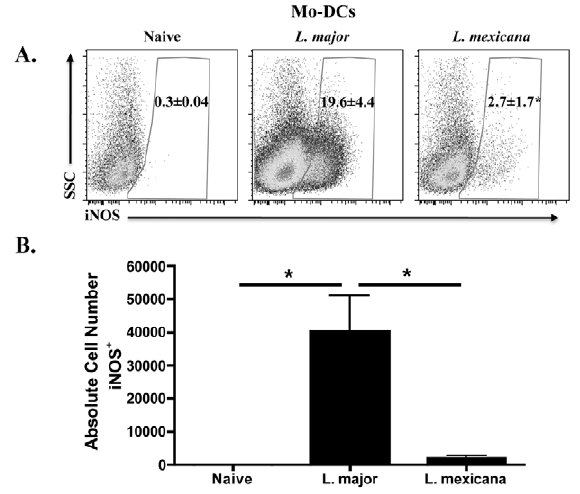
Figure 3. Mo-DCs produce significantly less iNOS during infection with L.mexicana compared to L.major . C57BL/6 mice were infected and ears were processed as above. In addition to staining for surface markers, intracellular staining for iNOS was performed. Percentage ( A ) or absolute number ( B ) of iNOS-producing cells in the ear of naı¨ve or infected mice on day 14. Cells are previously gated on live, singlets that are CD11b hi CD11c + . The results expressed are the mean percentage ( 6 SD for FACS plots) or the mean number of cells ( 6 SE for the bar graph) of 3 mice per group. The results are representative of two experiments. * significantly lower (p , 0.05) compared to L. major infected mice.